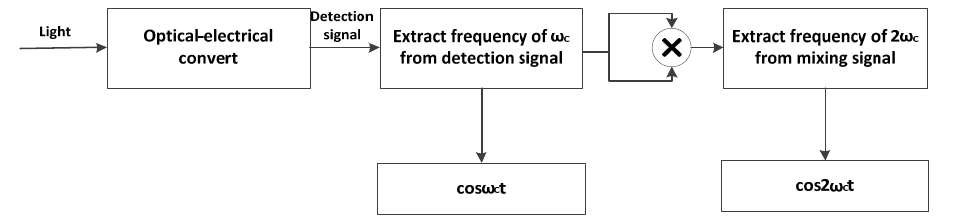
Figure 4. The progress of extracting the signal in frequency domain for mixing.